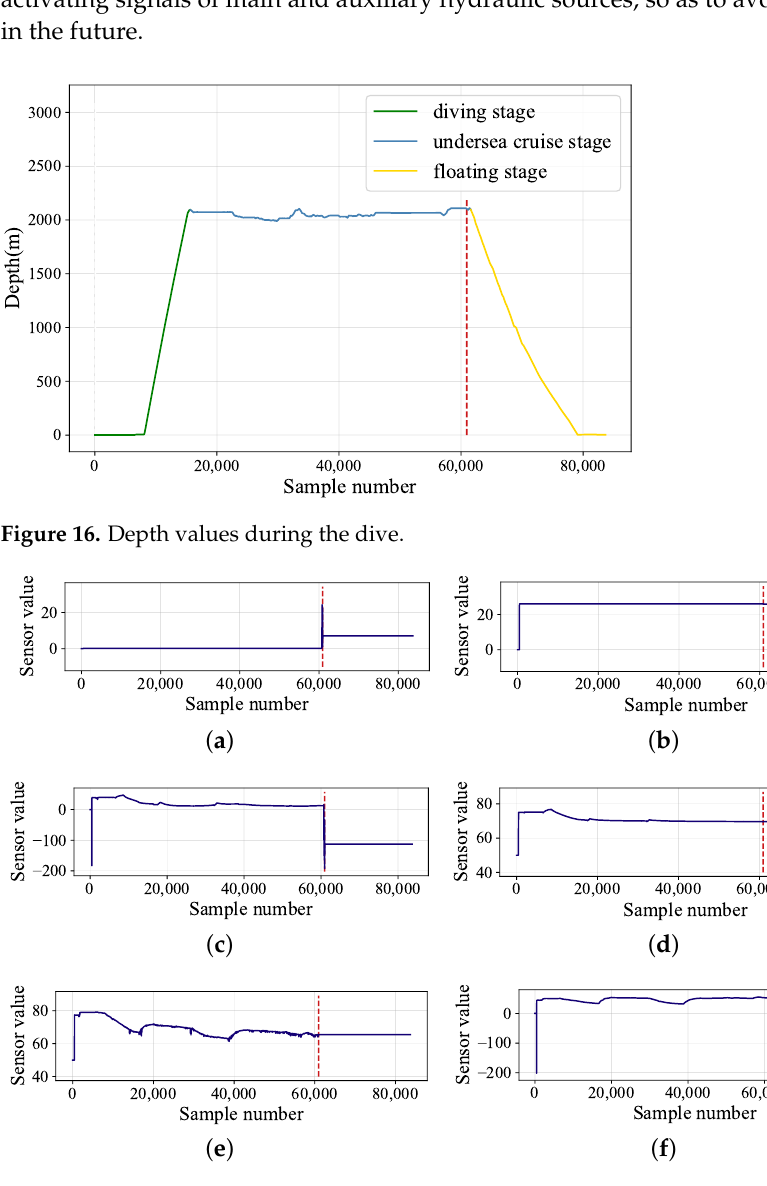
Figure 17. Sensor variables related to hydraulic system fault event: ( a ) current of 24V power; ( b ) tank pressure; ( c ) temperature of tank VP2; ( d ) displacement of compensator 10LPM; ( e ) displacement of compensator 15LPM; ( f ) temperature of tank